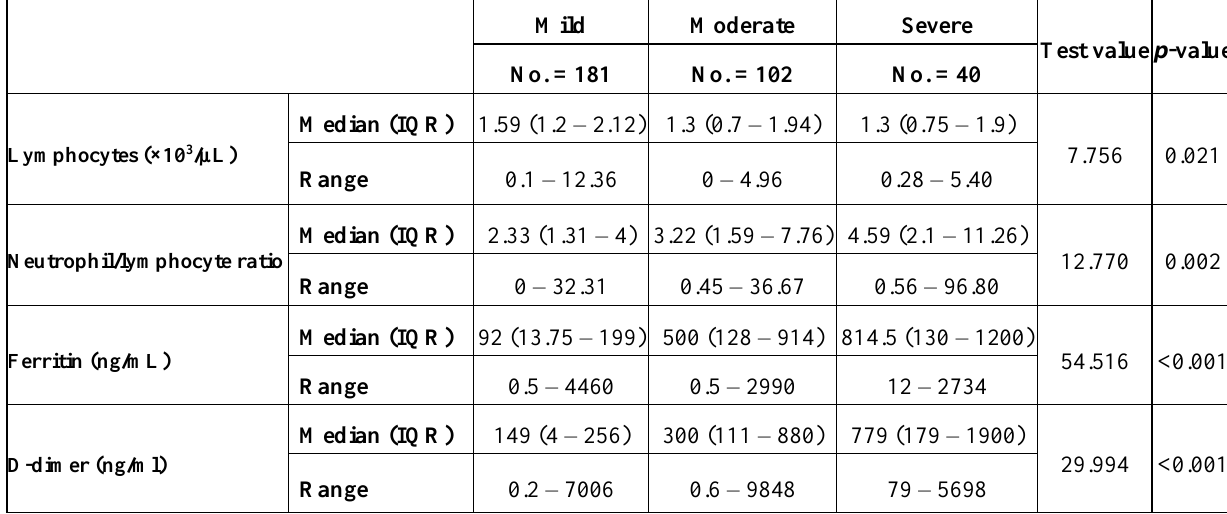
Table 2. The levels of lymphocytes count, neutrophil to lymphocyte ratio, D-dimer concentration, and serum ferritin among mild, moderate severe cases.